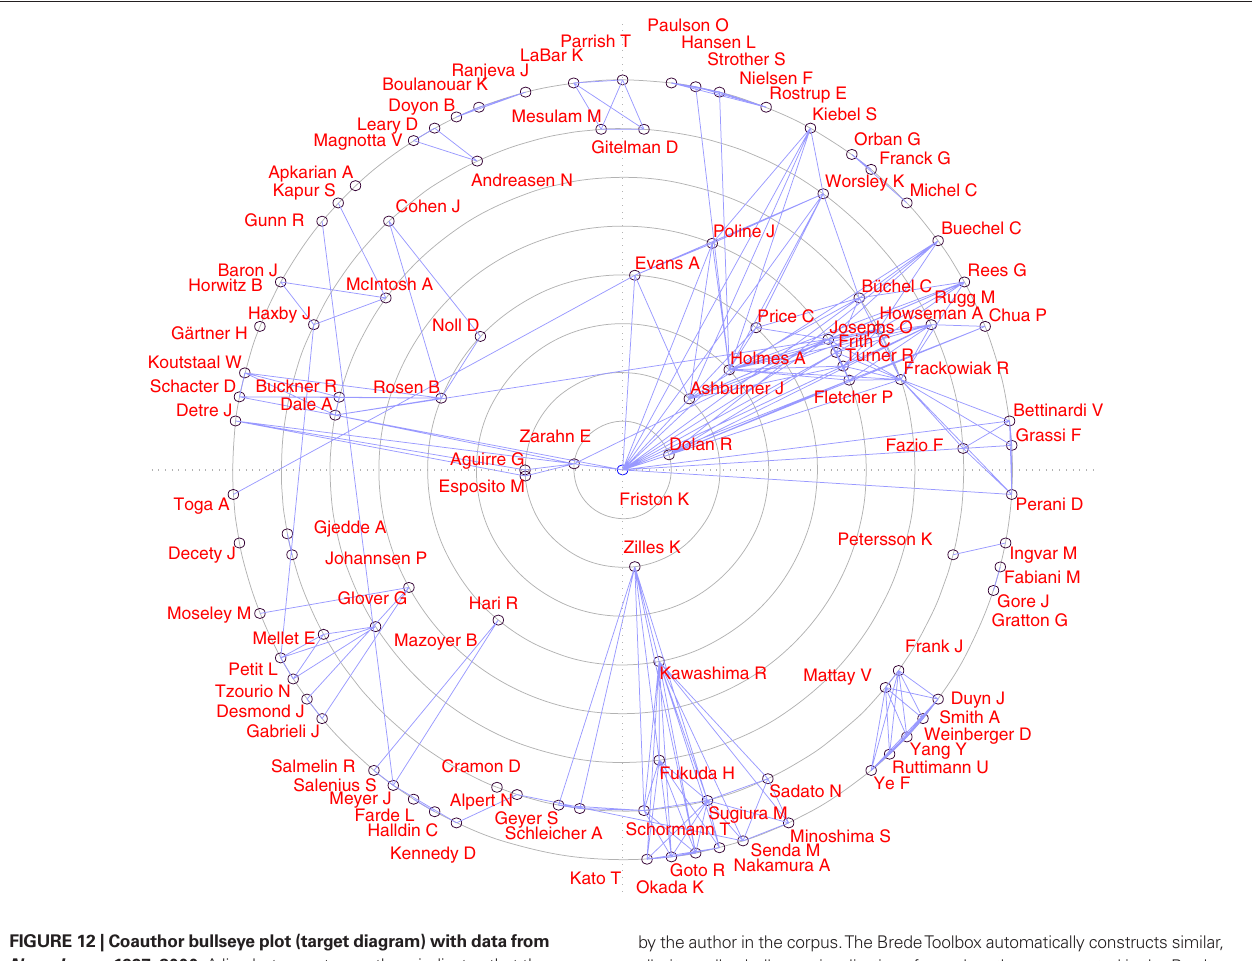
by the author in the corpus. The Brede Toolbox automatically constructs similar, albeit smaller, bullseye visualizations for each author represented in the Brede Database author ontology. These are available on the